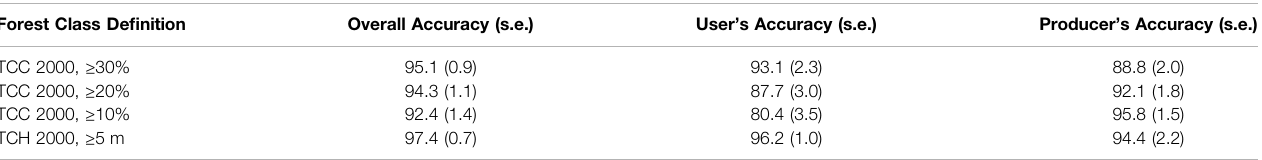
Standard errors of accuracy metrics are shown in